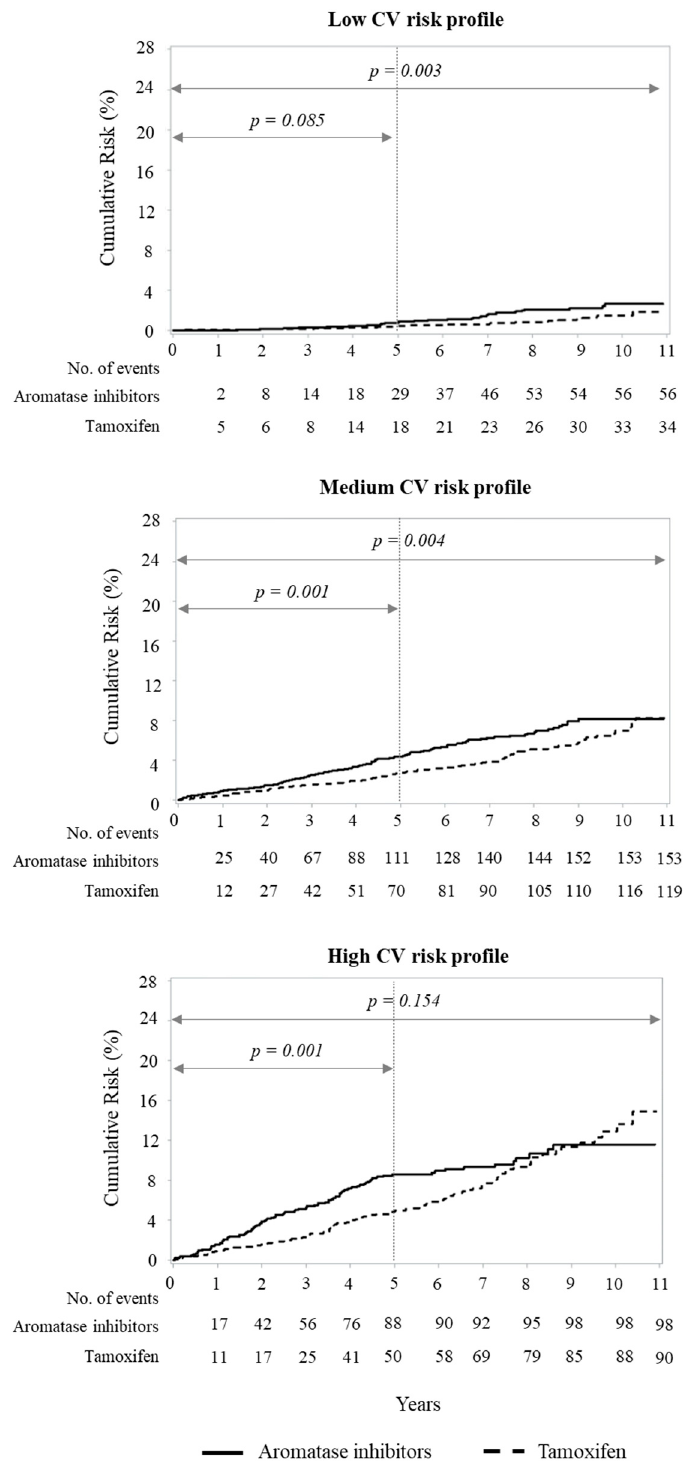
Figure 3. Kaplan–Meier estimates of the cumulative risk of heart failure in patients with breast cancer treated, respectively, with aromatase inhibitors (AI) and tamoxifen stratified by baseline CV risk. Cumulative risk over an 11-year horizon of heart failure in low CV profile ( top ), medium CV profile ( central ), and high CV profile ( bottom ) based on an intention-to-treat approach in which cohort women were classified on the therapy (aromatase inhibitors or tamoxifen) initially received. Patients were 1:1 matched by age at surgery.